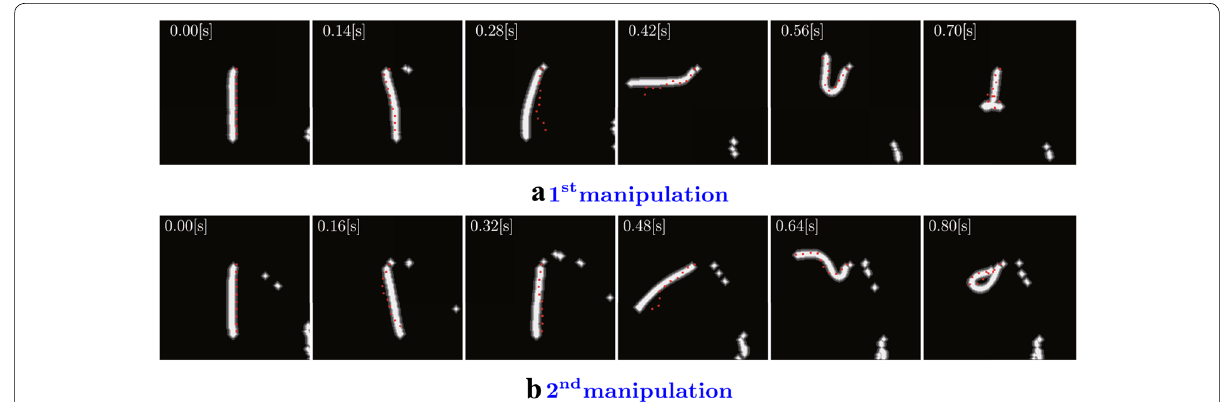
Fig. 13 Estimation result of string parameters